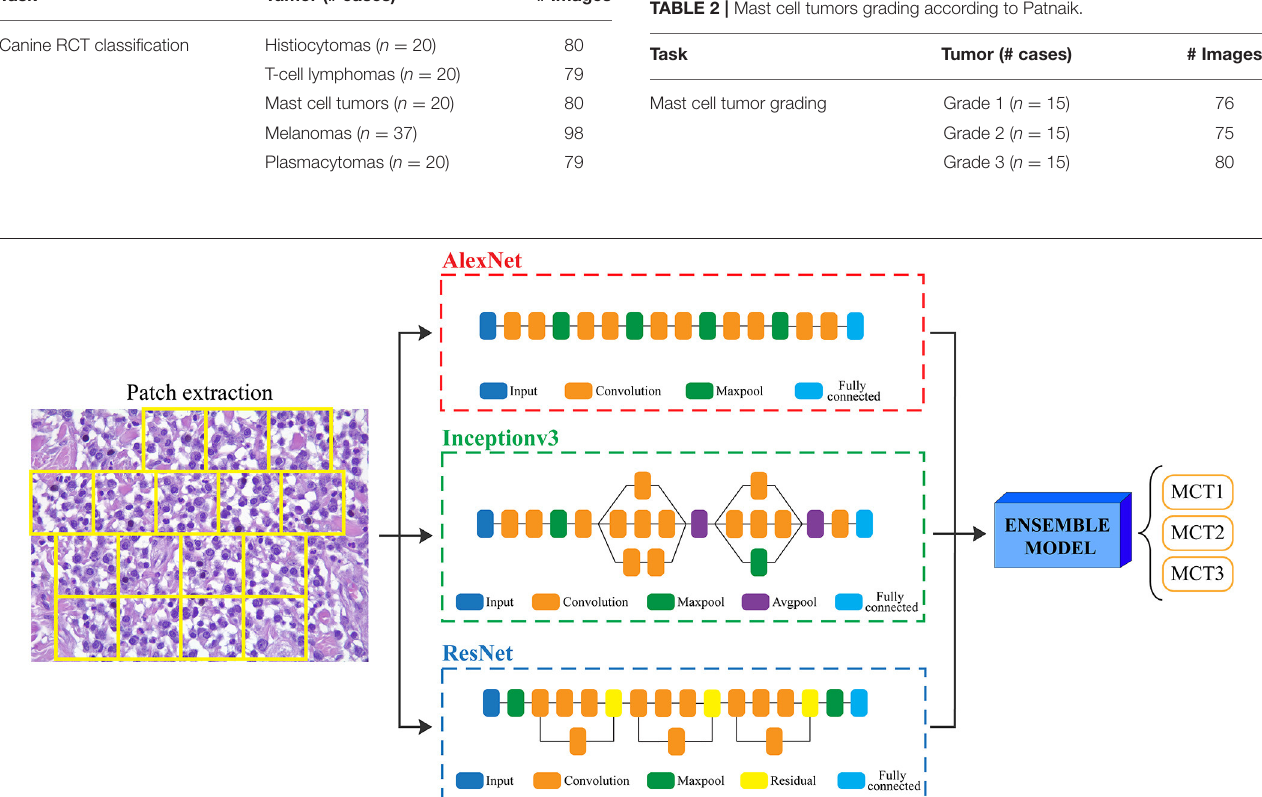
Frontiers in Veterinary Science |